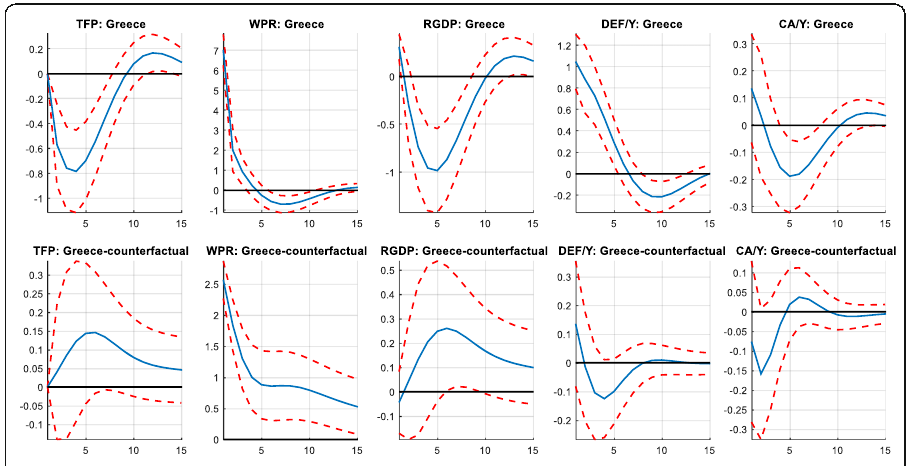
Fig. 7 Actual vs counterfactual responses to a shock in